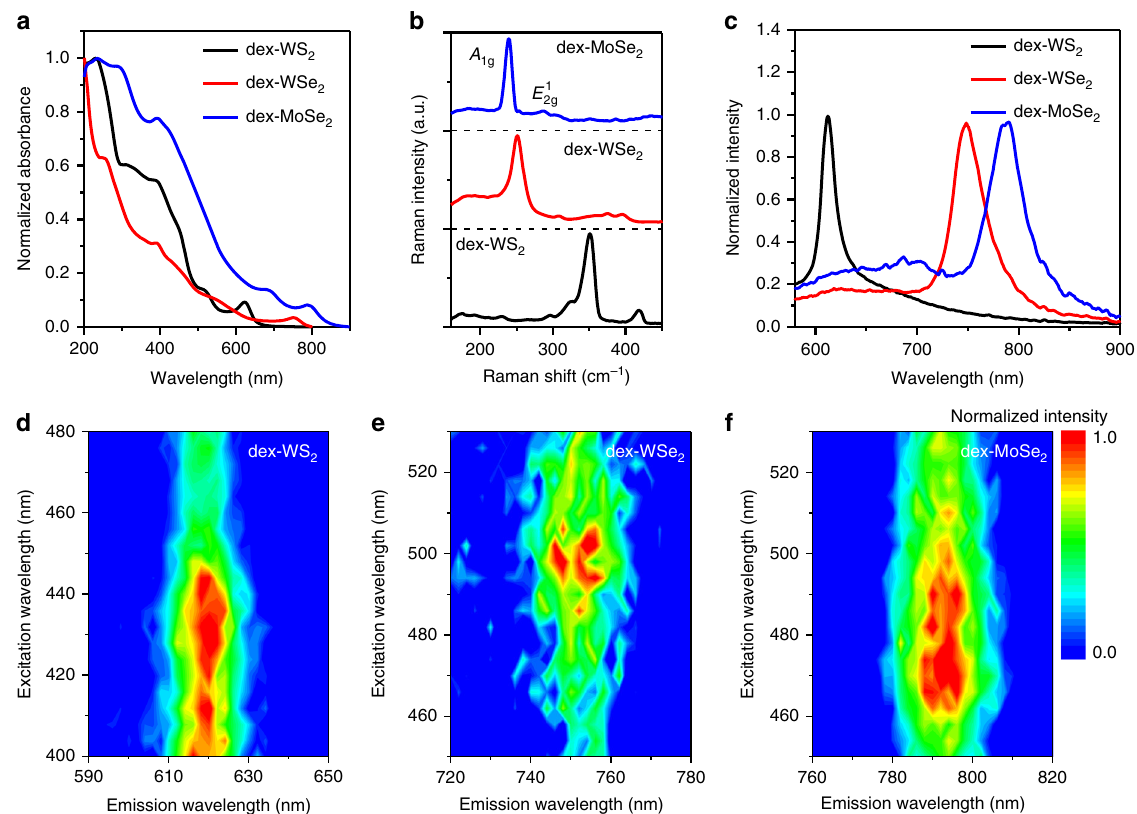
Fig. 2 Optical properties of dex-TMDs. a UV – Vis extinction spectra, b Raman spectra, and c photoluminescence spectra of dex-WS 2 , dex-WSe 2 , and dex- MoSe 2 nanosheets. A 532-nm excitation laser was used. Excitation/emission pro fi les of d dex-WS 2 , e dex-WSe 2 , and f dex-MoSe 2 ,